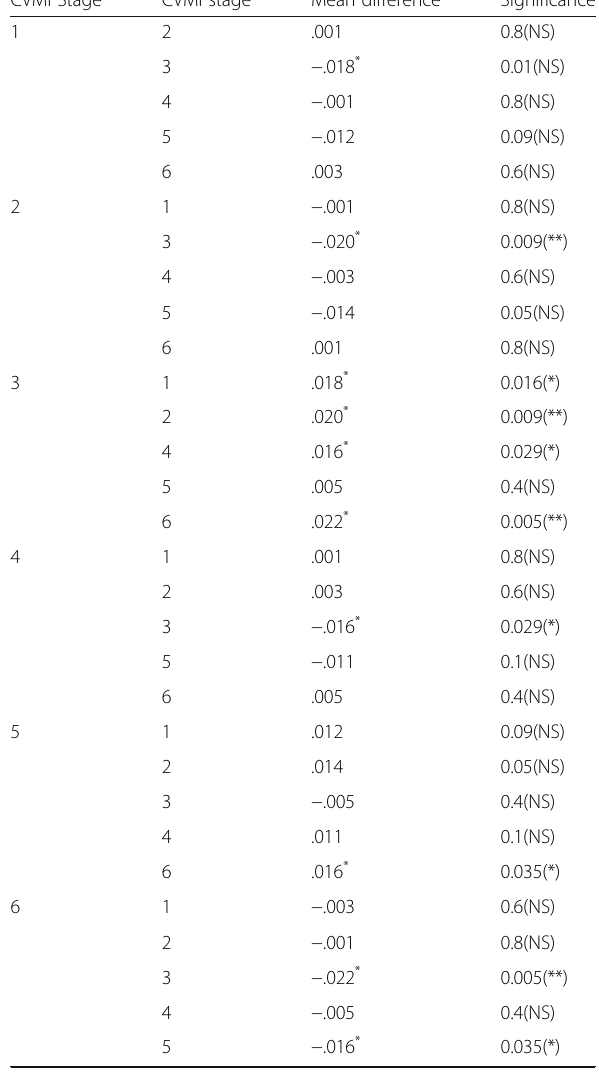
Table 6 Post-hoc analysis (least significant difference) comparing ratio of serum IGF-1 and IGFBP-3 for each of the six CVMI